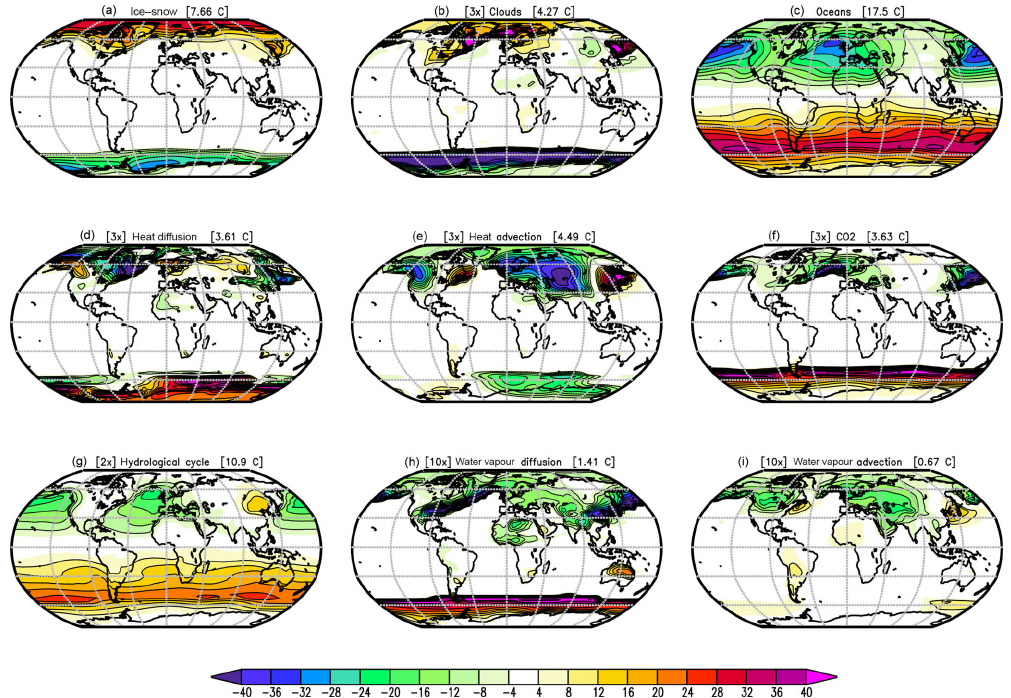
Figure 6. As in Fig. 5, but for the seasonal cycle. The mean seasonal cycle is defined by the difference between the months (JAS – JFM) divided by two. Positive values on the Northern Hemisphere indicate a stronger seasonal cycle in the sensitivity experiments than in the full GREB model and vice versa for the Southern Hemisphere. Global root mean square differences are shown in the headings. All values are in degrees Celsius ( ◦ C). In some panels, the values are scaled for better comparison: (b) , (d) , and (e) by a factor of 2; and (h) and (i) by a factor of 10. (g) The mean for the hydrological cycle experiments with and without the ice–albedo process active.